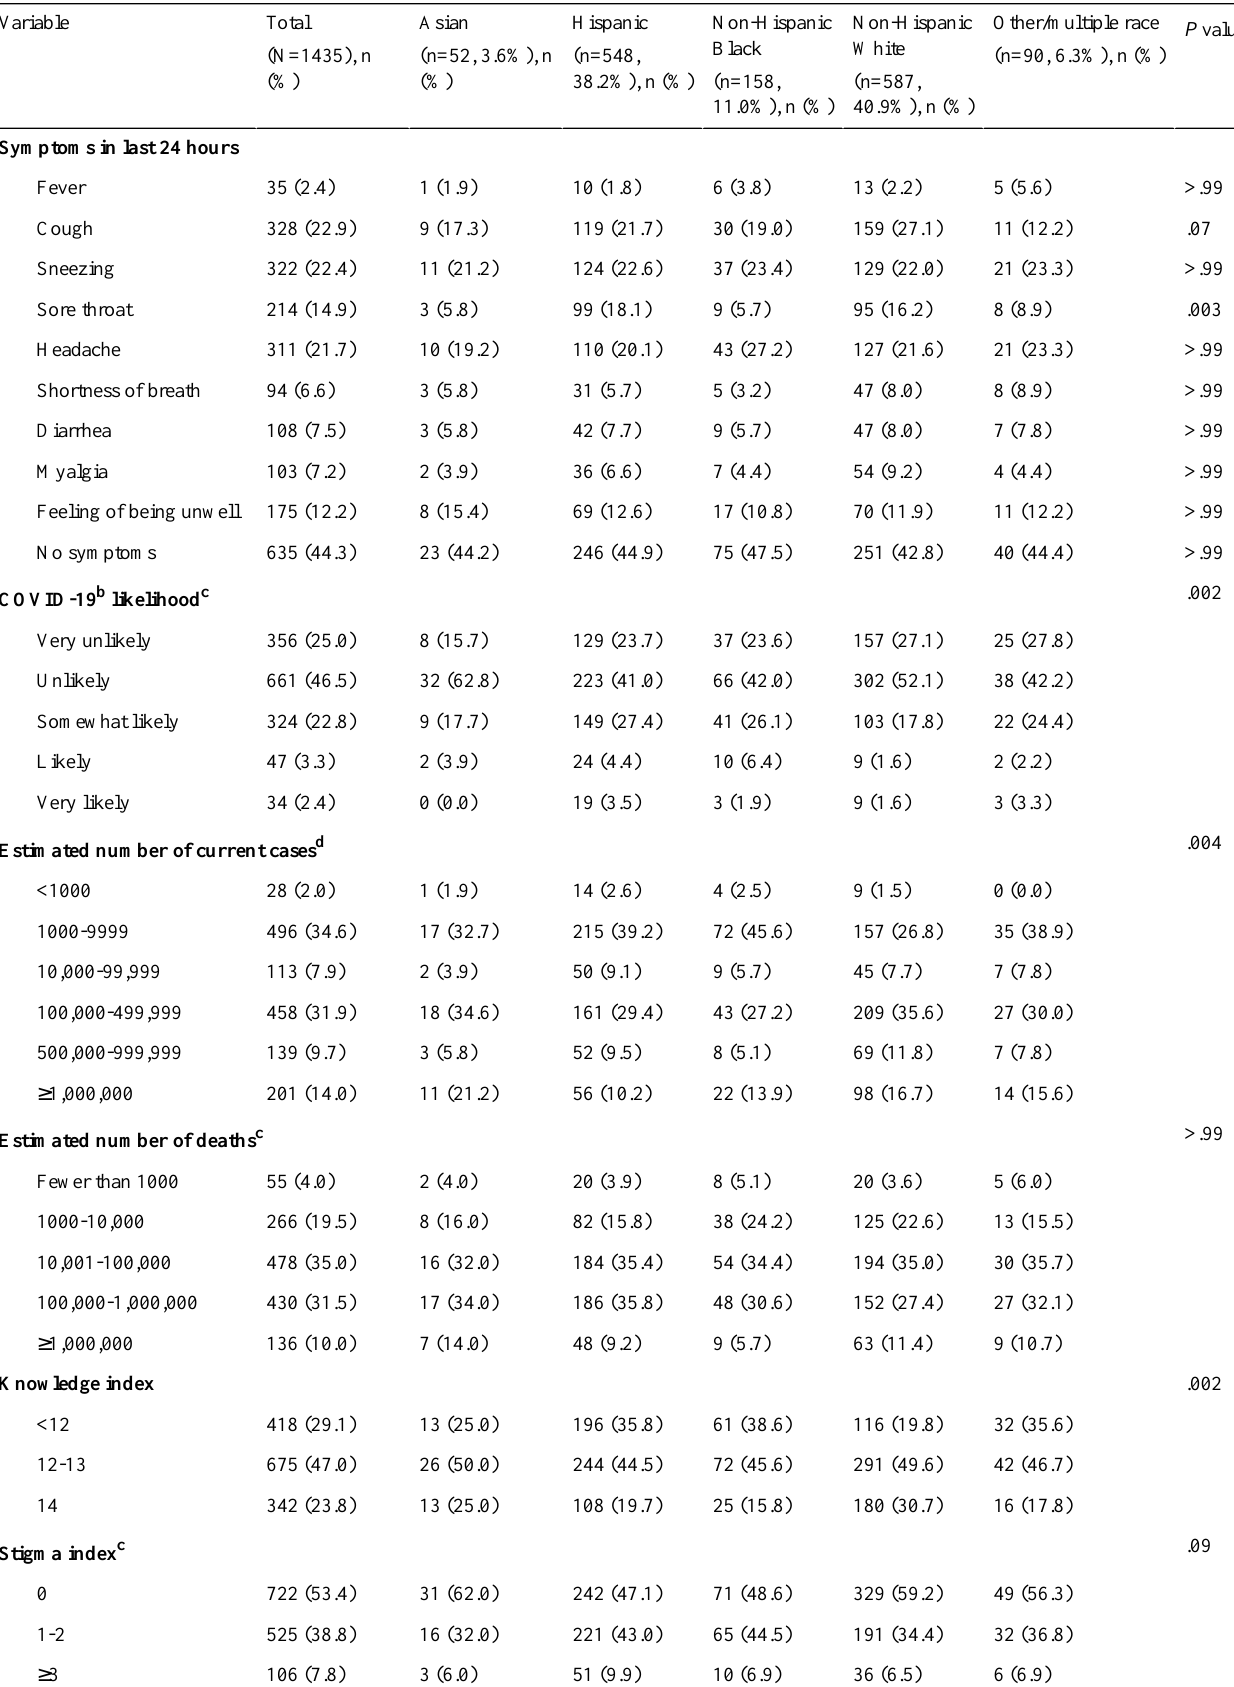
Table 2. Associations between race/ethnicity and symptoms, likelihood of current COVID-19 infection, estimates of the extent of the COVID-19 pandemic, knowledge, stigma, and interest in participating in research studies among participants in a web-based, cross-sectional survey conducted from March 27 through April 1, 2020